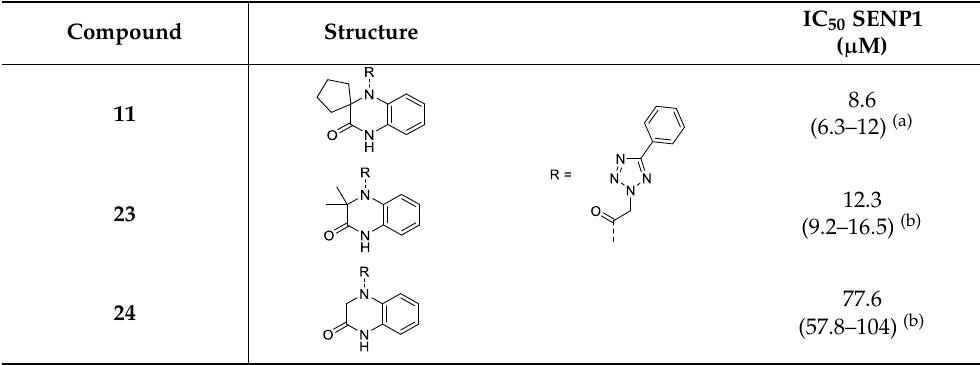
Table 1. IC 50 values of hit compound 11 and the corresponding modifications of the spiro DHQ scaffold 23 and 24 ; (a) n = 5; (b) n = 2. Compound